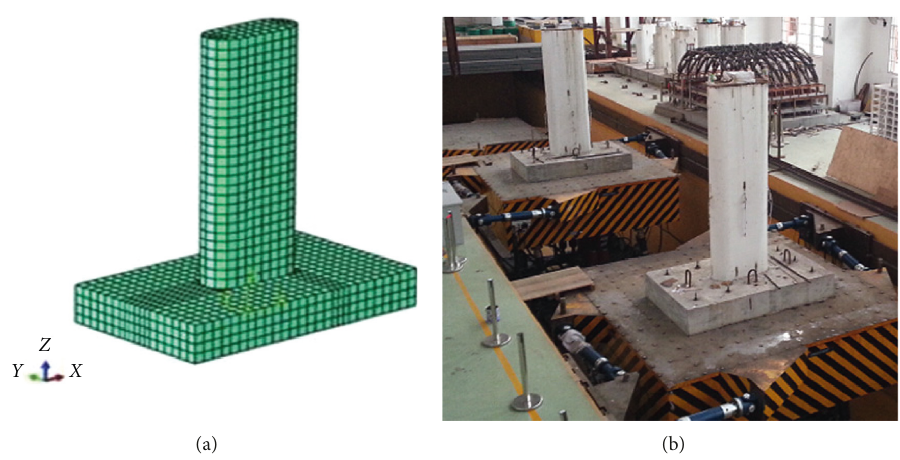
Figure 18: Shake table test with high-speed railway bridge piers. (a) Numerical model; (b) test specimens.